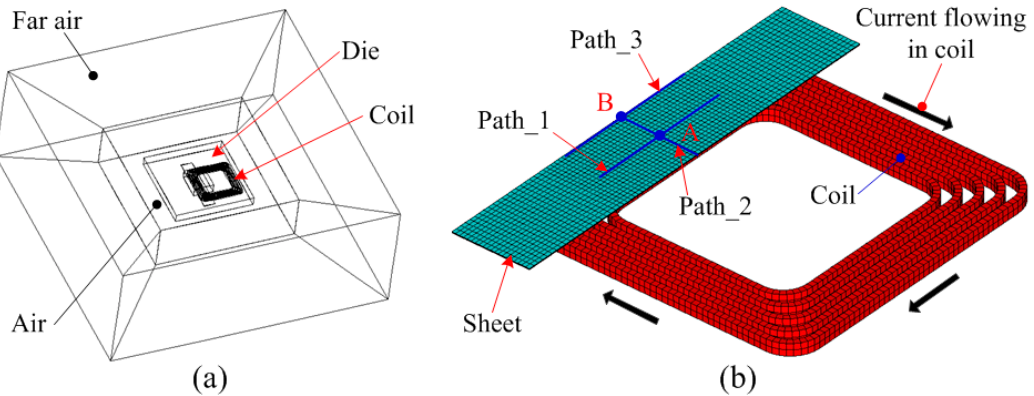
Figure 3. Finite-element models: ( a ) Electromagnetic field model and ( b ) coil and sheet.